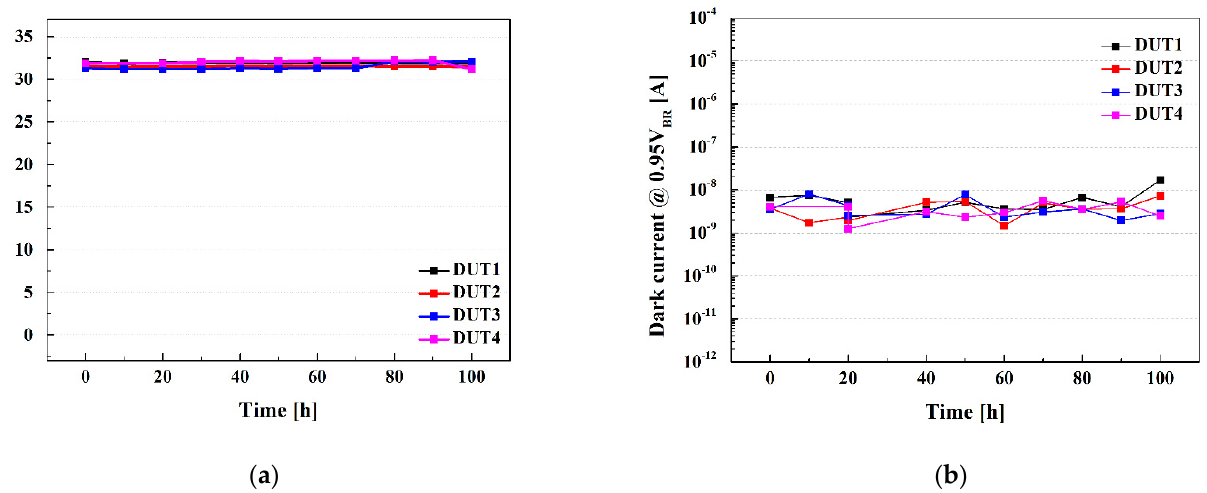
Figure 5. Monitored electrical characteristics of the ( a ) breakdown voltage (V BR ) and ( b ) dark current (I D ) at 498 K.